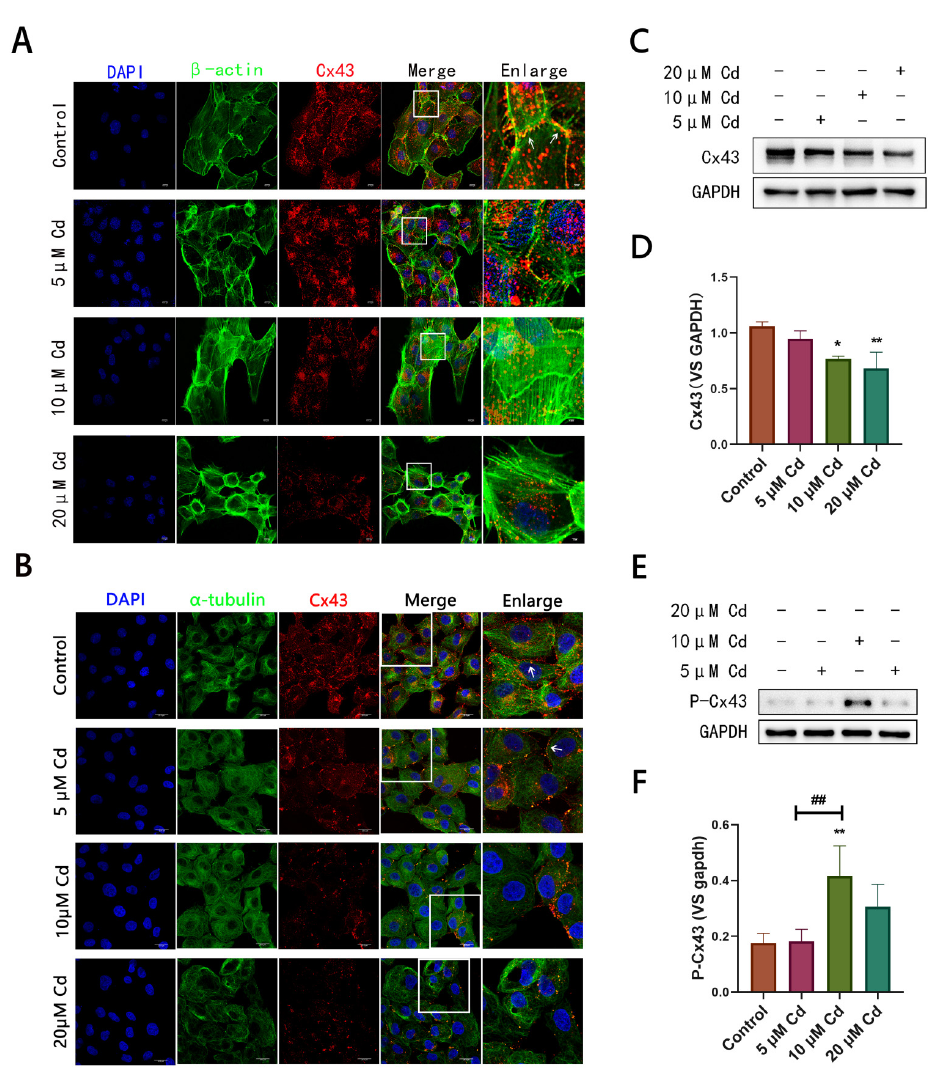
Figure 1. Cd induces Cx43 internalization and degradation in hepatocytes: ( A ) Cx43 was co-stained with microfilaments (labeled with phalloidin). Green represents microfilaments, and red represents Cx43. The white rectangle represents Cx43 between cells under different Cd concentrations. The white arrow represents GJP. Scale bar = 10 μ m; ( B ) Anti-Cx43 antibody was co-stained with anti- α -tubulin-FITC antibody. Green represents maicrotubules, and red represents Cx43. The white rectangle represents Cx43 between cells under different Cd concentrations. The white arrow represents GJP. Scale bar = 10 μ m; ( C , D ) Western blotting analysis of the Cx43 level in rat hepatocytes. Statistical results were obtained from at least three independent experiments; * p < 0.05 compared to the control group, ** p < 0.01 compared to the control group; ( E , F ) Western blotting analysis of P-Cx43 (Ser 373) level; ** p < 0.01 compared to the control group, ## p < 0.01 compared to the Cd group.